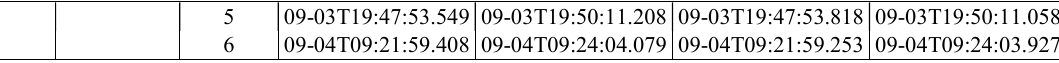
Table 2. Results comparison